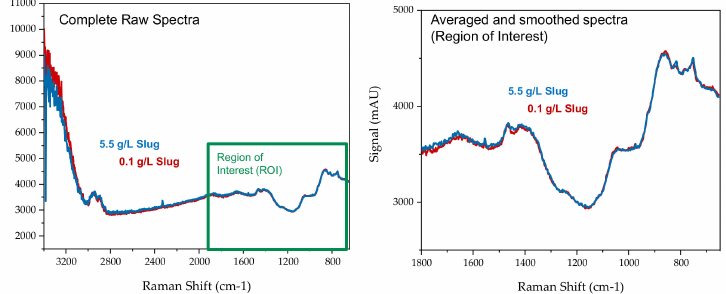
Figure 19. Raman spectra for mRNA concentrations of 0.1 g/L (red line) and 5.5 g/L (blue line). Fluorescence and Raman did not show sufficiently high sensitivity, as expected. How- ever, DAD and FTIR were an option for high and low concentrations.